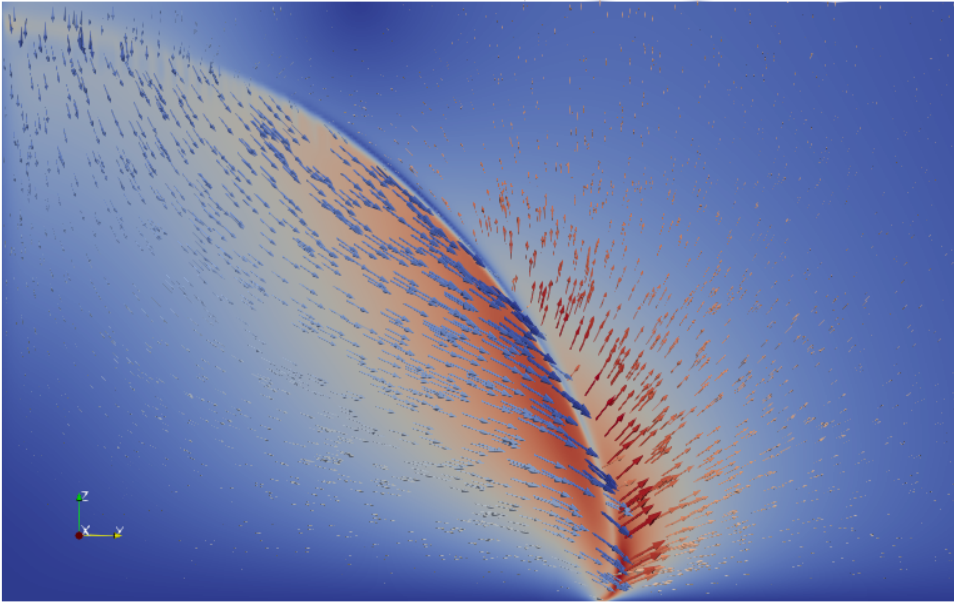
Figure 8. Velocity vectors from the cross section of a 3D simulation. Vectors are scaled by magnitude and colored by vertical component, with blue denoting downward velocity and red upward velocity. The background is colored by velocity magnitude, with blue denoting zero and red denoting high velocity. Strong downward motions are seen within the fluid mound (left), while strong updrafts are seen in the air being displaced by the advancing front (center right). The midpoint along the arc length of the interface is characterized by a nearly stagnant zone, where velocity changes from negative at left to positive at right with respect to the interface outward normal